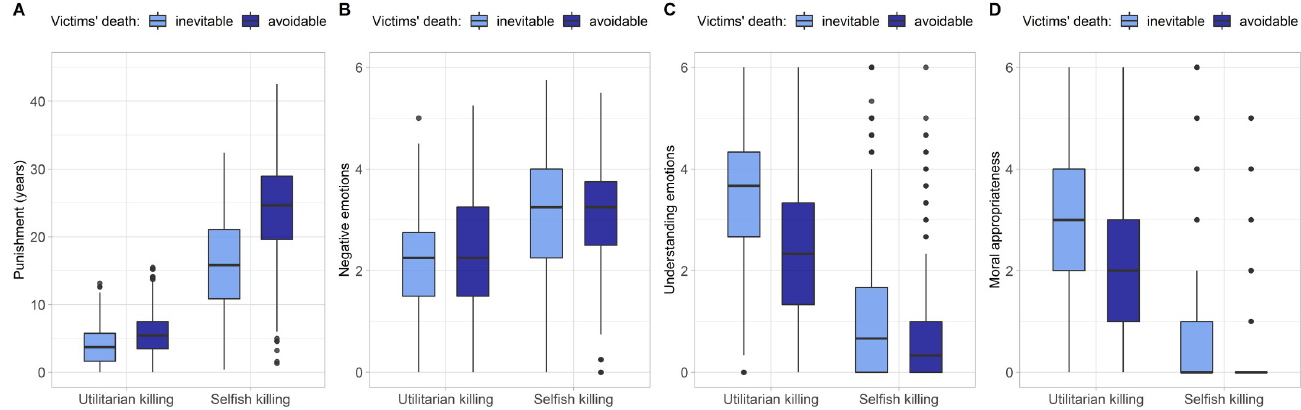
Fig 1. Influence of motive for killing and avoidability of victims’ death. On (A) assigned punishments, (B) observers’ negative and (C) understanding emotions towards perpetrators, and (D) moral appropriateness ratings.